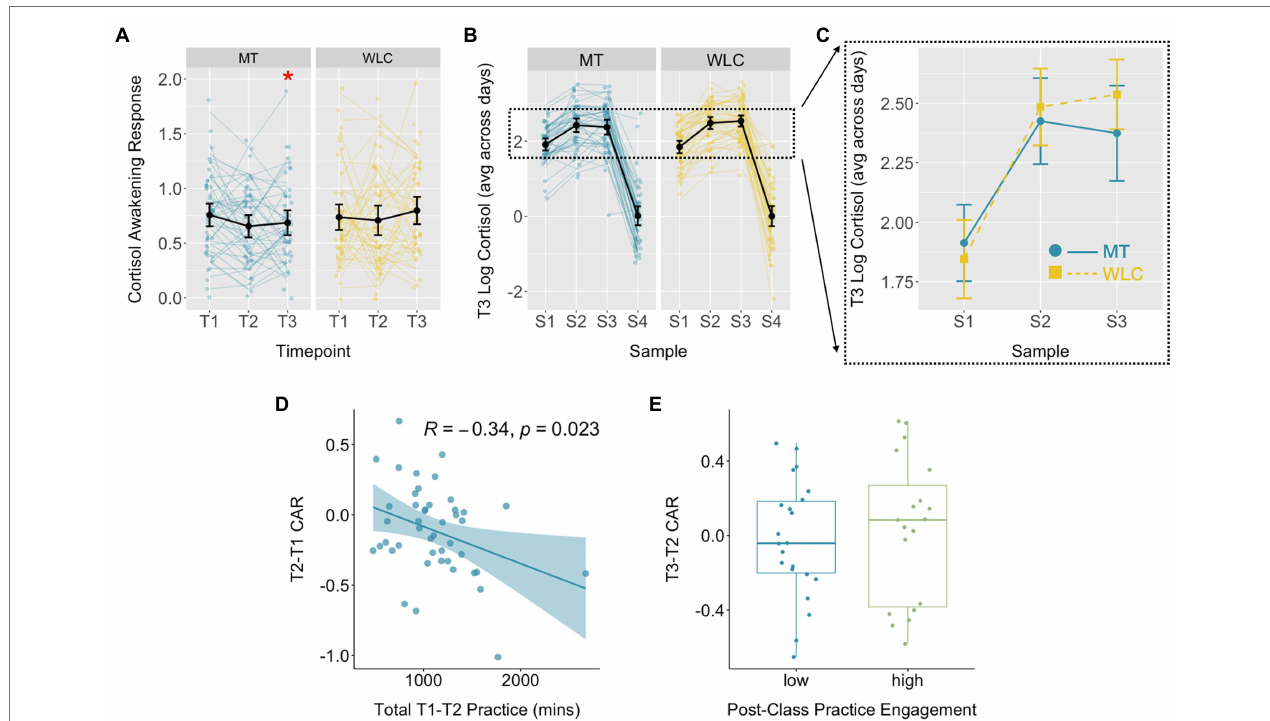
FIGURE 3 | Effects of mindfulness training on the CAR. (A) Log-transformed CAR for the MT and WLC groups at baseline (T1), post-mindfulness training (T2), and 3-month follow-up (T3). Controlling for T1 CAR, the MT group had a significantly lower CAR at T3 relative to WLC [ t (195.3) = 2.31, p = 0.02]. (B,C) Log cortisol values at each of four sampling times for T3 show a steeper rise in cortisol between S1 (awakening) and S2 (30 min) for the WLC vs. MT group. Group means diverge further at S3 (45 min), with the WLC group showing a slight increase and the MT group a slight decrease. (D) Within the MT group, greater formal mindfulness practice during the 8-week class was associated with a greater reduction in the CAR between T1 and T2. (E) There was no difference between groups with relatively high vs. low practice engagement between post-training and follow-up assessments and changes in the CAR over the same interval. Summary statistics are within- group means with 95%